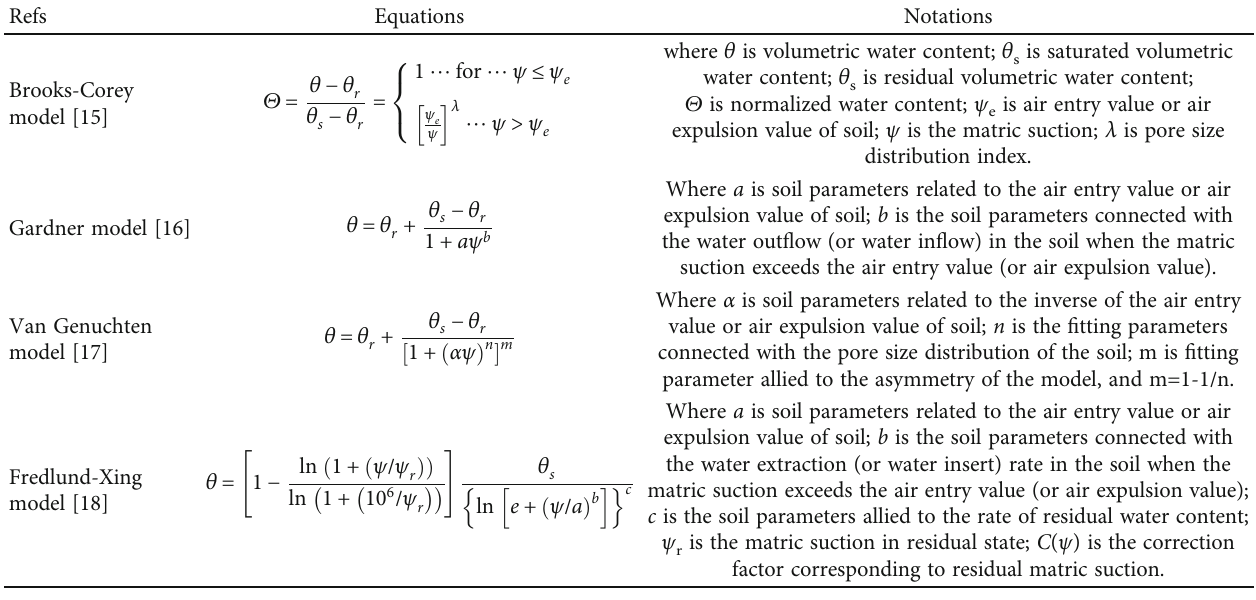
Table 1: Typical SWCC equations for the fi rst category of methods from the literature.